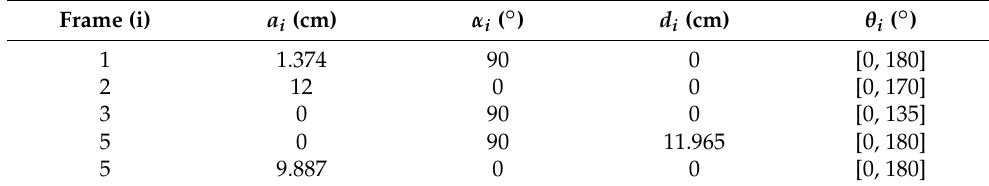
Figure 2. ( a ) A 3D rendering of the 5-DOF robot manipulator. ( b ) Kinematic and frames representations. Table 1. Denavit–Hartenberg parameters of the 5-DOF robotic